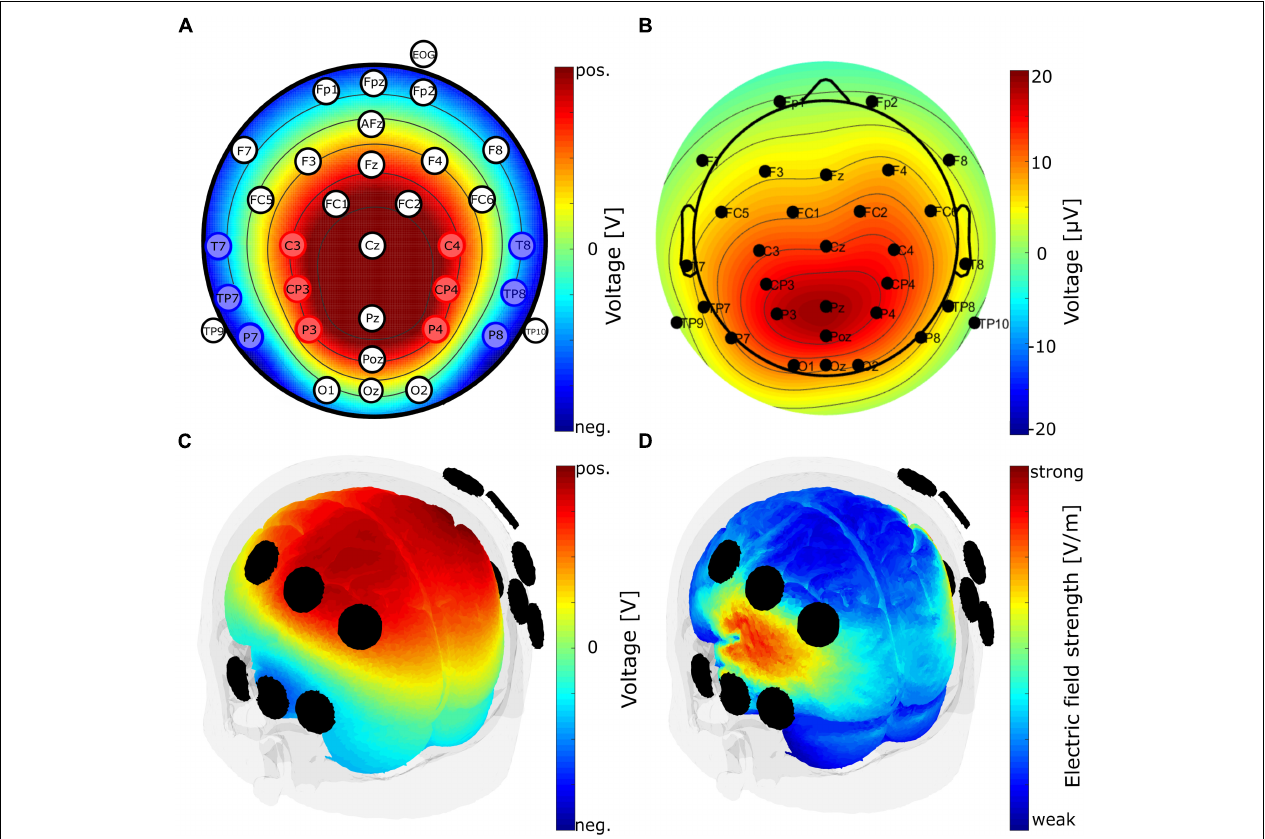
FIGURE 1 | Electrode configuration and finite element modeling of the electrode clusters. (A) Electrode positions of the EEG electrodes according to the international 10-10 system. Red and blue positions indicate electrodes used for tACS in block 2 of the experiment. Electrodes used for tACS are arranged in two electrode clusters, red and blue. Each cluster is used as one tACS electrode (alternatingly anode or cathode). Color map shows voltage topography on the scalp resulting from the two clusters of stimulation electrodes. Depicted is the case of the medial cluster being the anode and the lateral cluster being the cathode. TACS amplitude was set to 1 mA peak-to-peak. Voltage was adjusted automatically by the stimulation device according to individual electrode impedances. (B) P300 component topography of the EEG baseline block, averaged over subjects at the subject’s individual P300 peak latency. (C) Voltage topography distribution on brain surface obtained from finite element modeling using the mentioned stimulation electrode clusters and a current strength of 1 mA peak-to-peak. (D) Electric field distribution on brain surface obtained from finite element modeling with the same parameters as in (C)